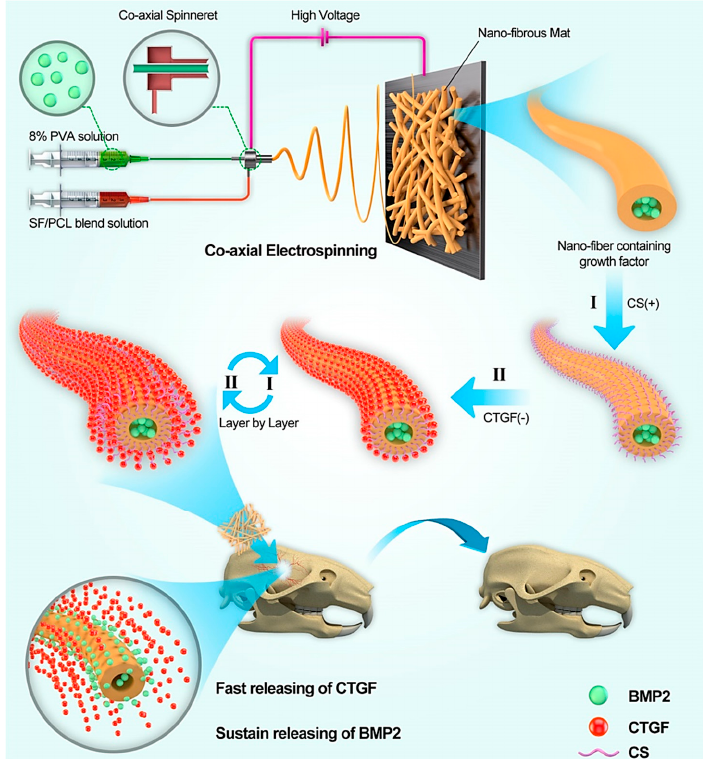
Figure 3. Schematic illustration of the bone healing process via controlled co-delivery of connective tissue growth factor (CTGF) and bone morphogenic protein-2 (BMP2) by combining the technique of coaxial electrospinning and layer-by-layer (LBL) process. BMP2 and CTGF were incorporated and attached to the core and the surface of the nanofibers, respectively (adapted from Cheng et al. [246] ). SF: silk fibroin and CS: chitosan.